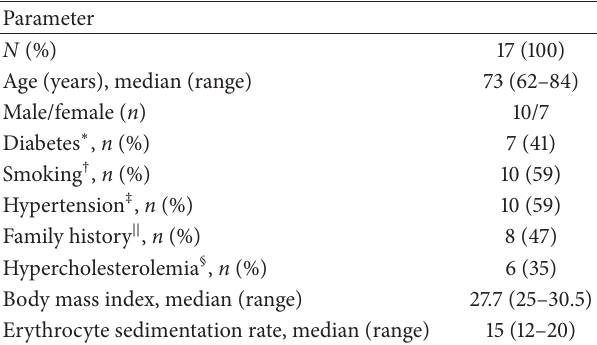
Table 1: Baseline characteristics of the 17 patients with carotid